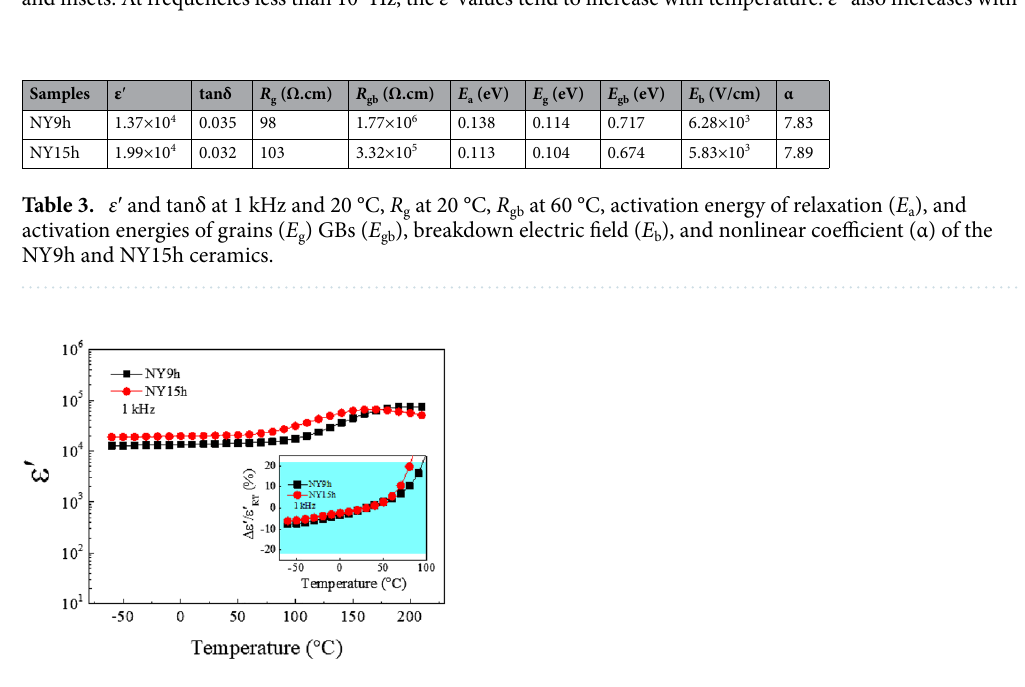
Figure 5. Temperature dependence of ε ′ at 1 kHz of NY9h and NY15h ceramics. Its inset shows the temperature coefficient of ε ′ at 1